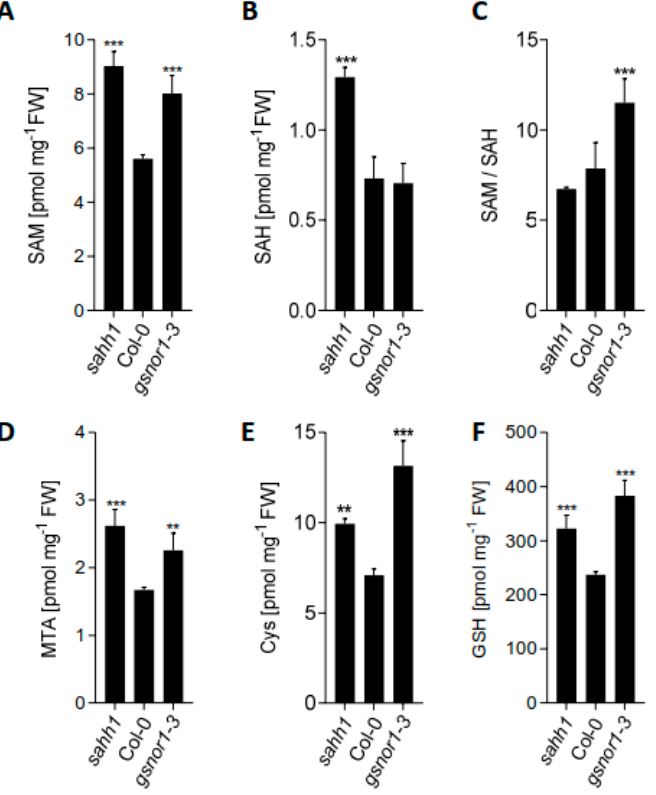
Figure 1. Mutations in GSNOR1 and S AHH1 result in an impaired methylation cycle. Analysis of steady-state levels of ( A ) SAM, ( B ) SAH, ( C ) SAM/SAH, ( D ) MTA, ( E ) Cys, and ( F ) GSH in 4-week- old rosette leaves grown under long-day conditions and harvested 5 h after the day-time start ( n = 5). Values are normalized against total fresh weight and represent the mean ± SD. Grubb ´ s outlier test ( α = 0.05) was performed. ** ( p < 0.01) and *** ( p < 0.001) represent significant differences between wt and mutants (ANOVA with Dunnett ´ s multiple comparisons test). Statistical analysis was performed with GraphPad Prism version 7.05.